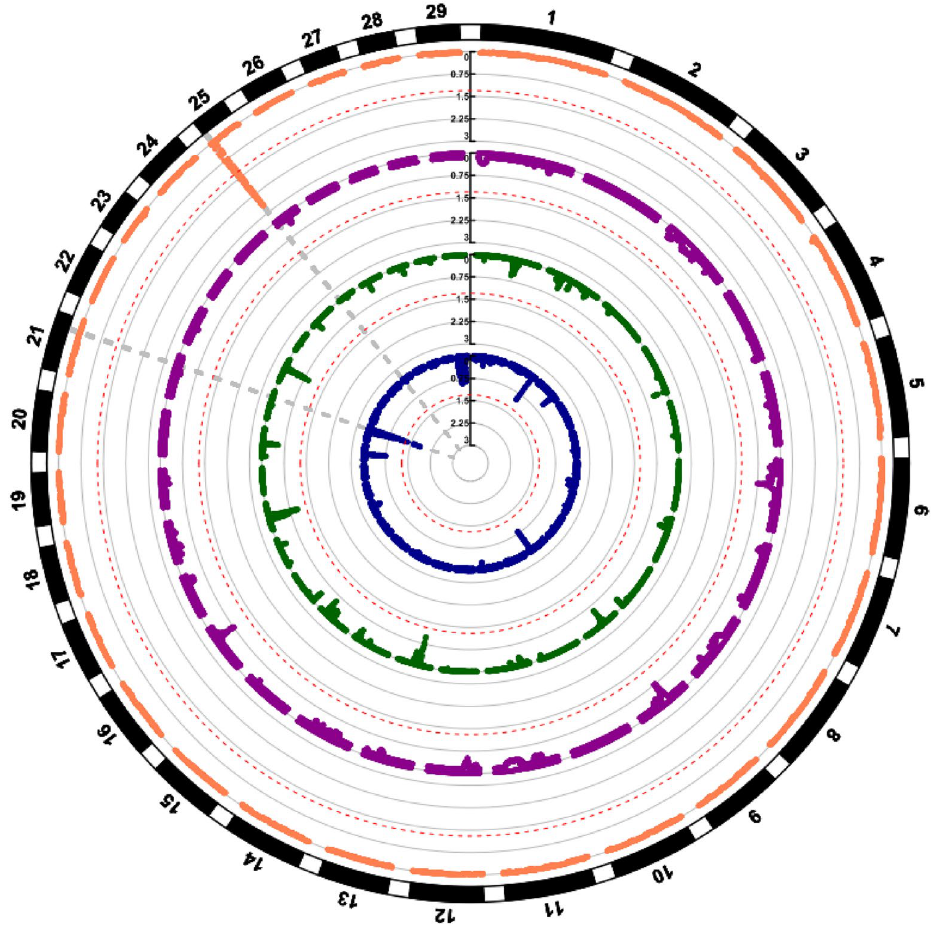
Figure 7. Circular Manhattan plot of selective sweeps detected with HapFLK. One different colour is the same to each breed: coral for Saanen, purple for Nubian, green for Boer and blue for Angora. The red dashed line indicates the threshold of significance of 0.05%. The grey dashed line indicates the two significant peaks in the CH25 (Saanen) and CH21 (Angora).